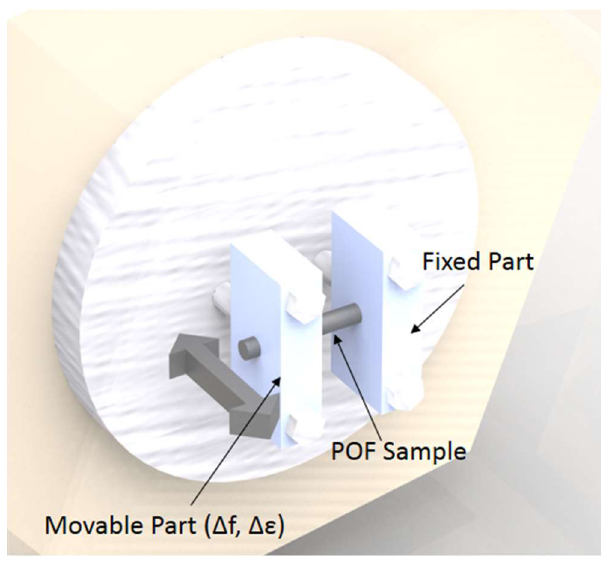
Figure 3. Polymer optical fiber (POF) fixation in the dynamic mechanical analysis (DMA) used in the Young’s modulus characterization with respect to the frequency.